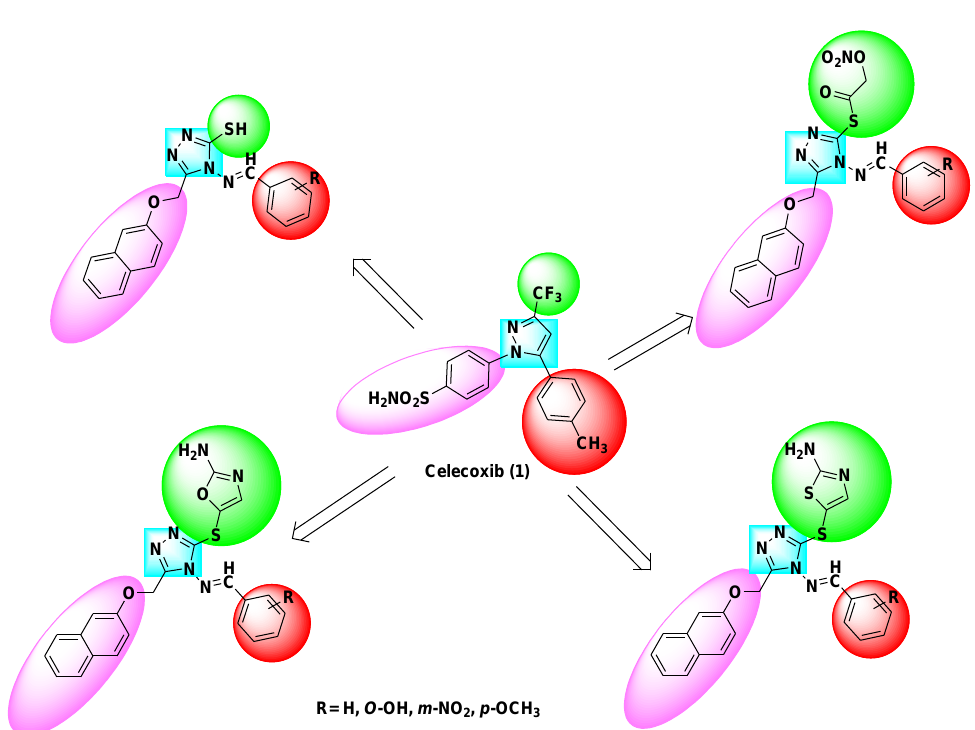
Figure 2. Chemical structure of the selective COX-2 inhibitor Celecoxib (1) and the designed compounds 9a–d , 10a–d , 11a–d , and 12a–d .